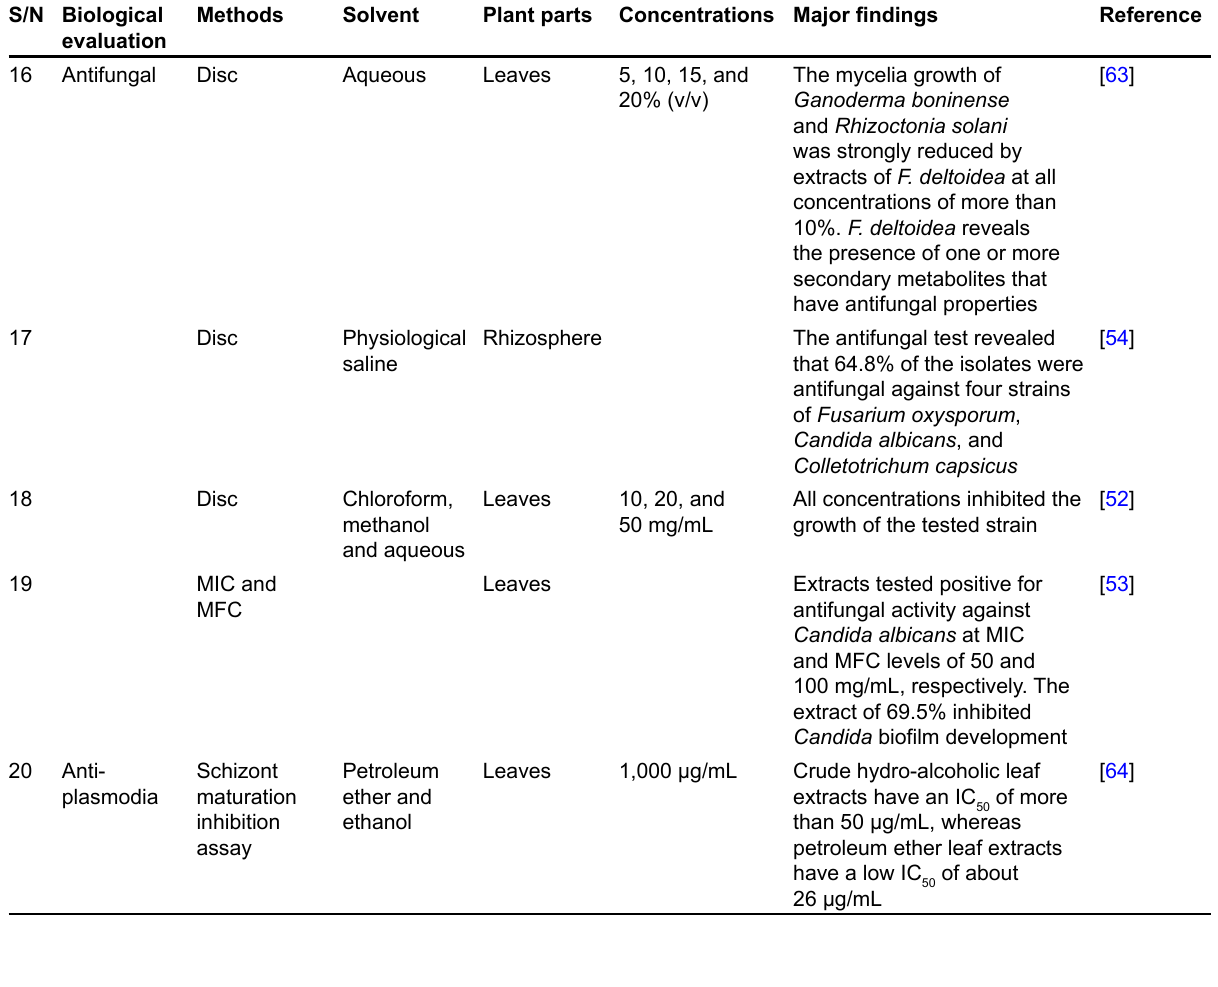
Table 3. Antimicrobial activity of FD ( continued )